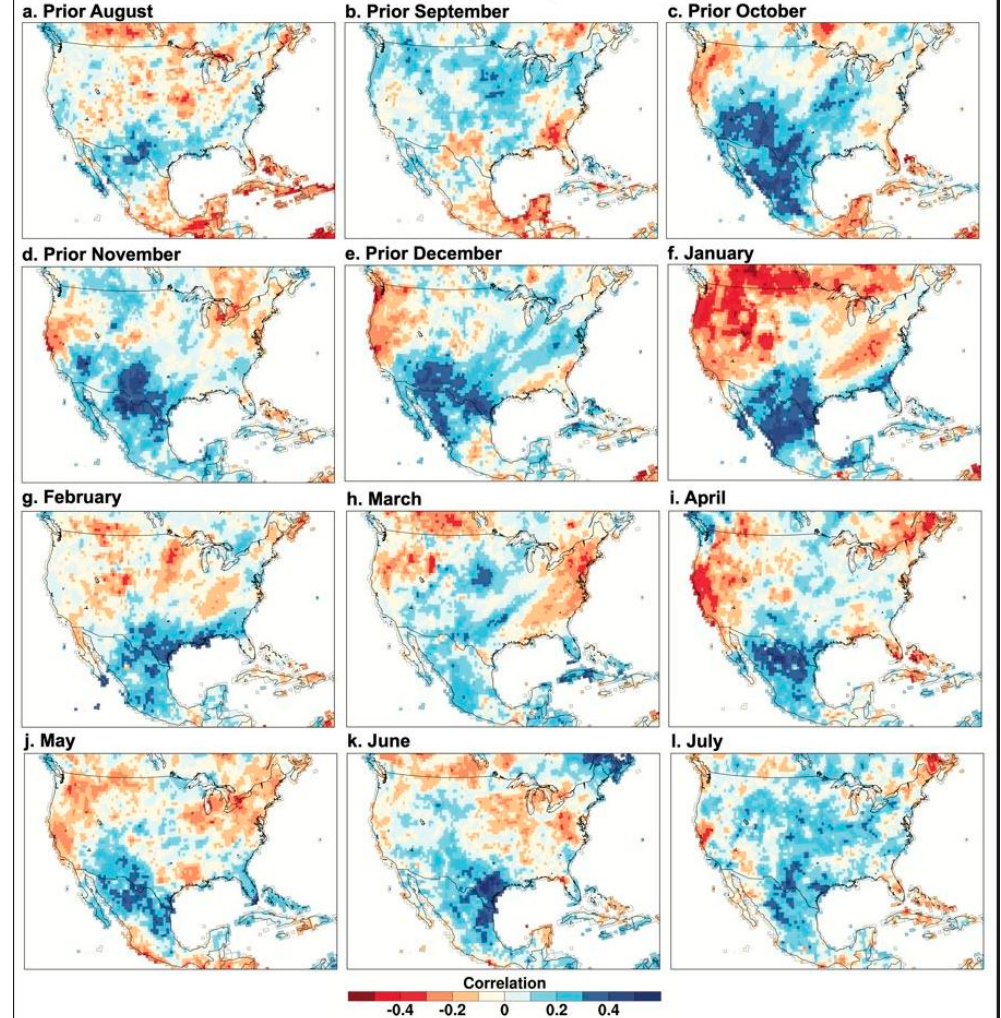
Figure 4. PC1 of the Borderlands tree-ring chronologies correlated with monthly precipitation data, 1946–2000. The time series scores for the first principal component of tree growth for the 12 detrended and standardized ring-width chronologies are correlated with gridded monthly precipitation totals over North America. The precipitation data were obtained from the GPCC with a grid spacing of 0.5° [24], and the correlations were all based on the common period 1946–2000 when the tree ring and instrumental precipitation data are well replicated.